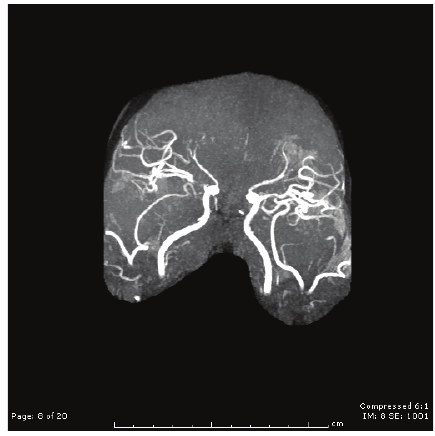
Figure 4: MRA showing pruning of bilateral ACA territory.